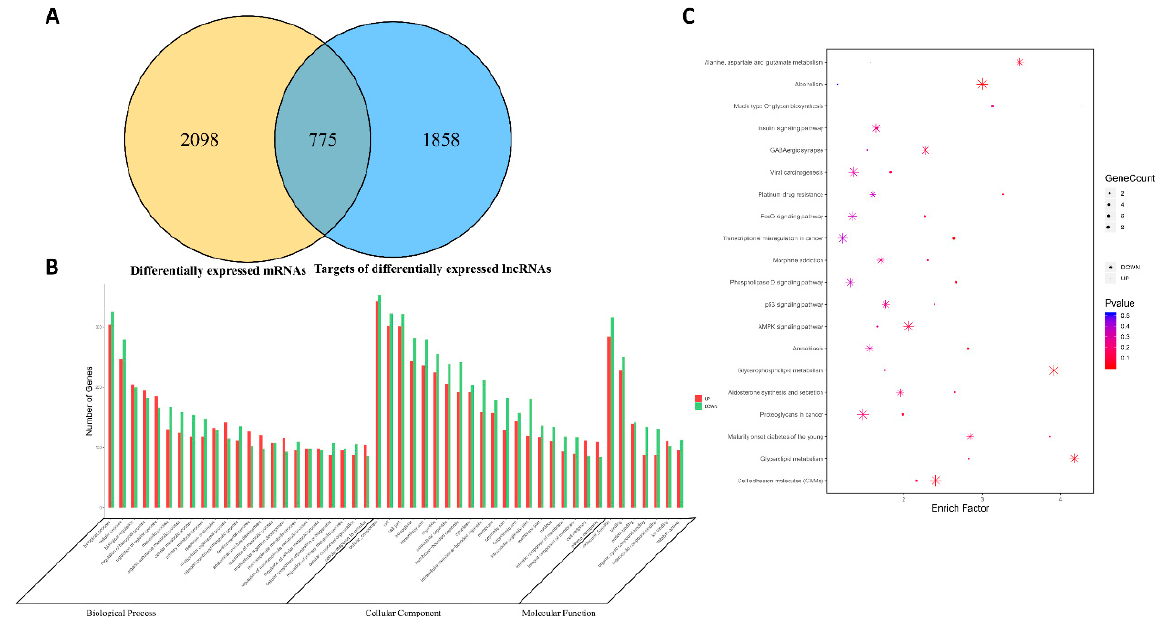
Figure 4. Functional prediction of DE LncRNAs and identification of LncRNAs related to apoptosis. ( A ) Venn diagram shows the number of overlap genes in target genes of differentially expressed lncRNAs. ( B ) GO analysis of the overlap genes in target genes of differentially expressed lncRNAs. The Y axis shows the number of DE genes, and the X axis shows the GO terms. All GO terms are grouped into biological process, cellular components and molecular function. The red bar represents the number of up-regulated genes, and the blue bar represents the number of down-regulated genes. ( C ) KEGG analysis of the overlap genes in target genes of differentially expressed lncRNAs. In this graphic, the degree of KEGG enrichment is assessed by the GeneRatio, p -value, and GeneCount. The closer the p -value is to zero, the greater the GeneRatio is. The greater the GeneCount is, the more significant the enrichment is.